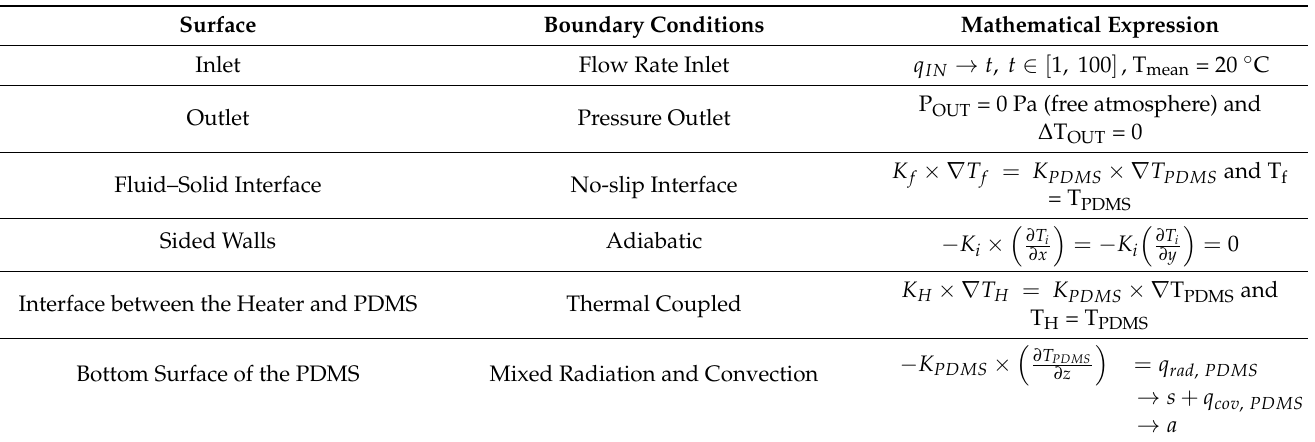
Table 4. Boundary conditions used in the current simulation for solid and fluid